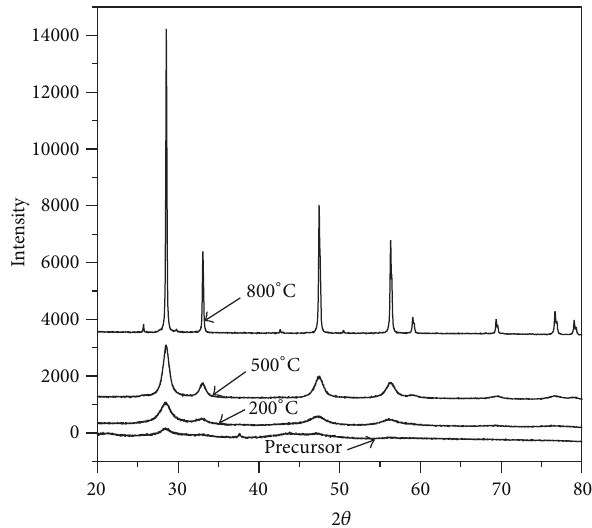
Figure 3: XRD plots of cerium carbonate precursor and cerium oxides annealed at different temperatures.